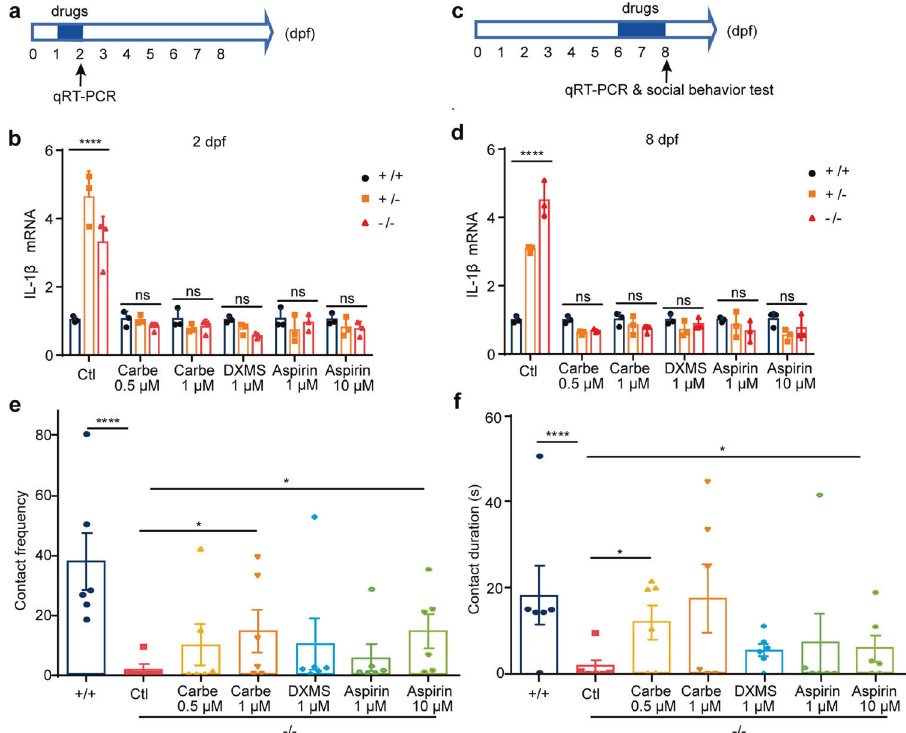
Fig. 6 Administration of oxytocin analogue, dexamethasone and aspirin restores immune response and social behavior in zebra fi sh. a Experimental set-up and drugs exposure to 1-day-old embryos. Zebra fi sh larvea are performed with different concentration drugs (carbetocin, dexamethasone, or aspirin), respectively. qRT-PCR analysis of the relative transcription level of IL-1 β at 2 dpf upon three groups. b Carbetocin, DXMS, and aspirin markedly decreases expression of pro-in fl ammatory cytokines IL-1 β , Ctl, egg-water administration,